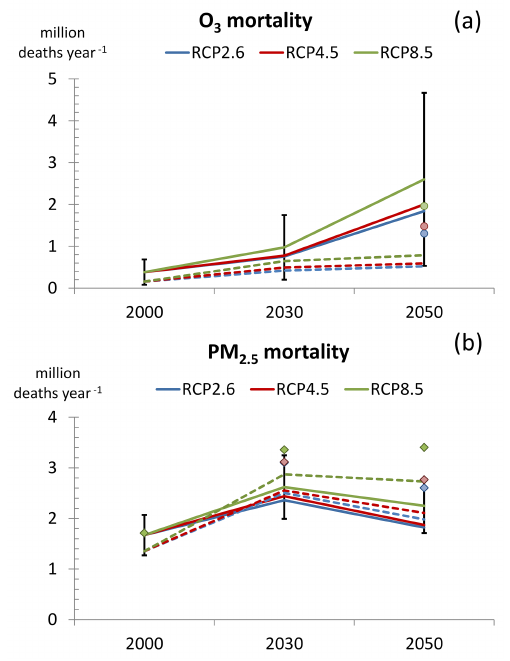
Figure 17. Trends in global burden on mortality of ozone (a) and PM 2 . 5 (b) from the years 2000 to 2050 from the ACCMIP multi-model ensemble (Silva et al., 2016) (full lines) and TM5- FASST (dashed lines) for three RCP scenarios. The error bar on the year 2000 is the ACCMIP 95% CI including uncertainty in RR and across models. CIs for 2030 and 2050 were not provided by ACCMIP; we use here the same relative error as for the year 2000. Dots (O 3 mortality) show the adjusted TM5-FASST ozone mortal- ities for RCP 2050, using baseline respiratory mortalities consis- tent with Silva et al. (2016). Diamonds (PM 2 . 5 mortality) show the TM5-FASST estimate including the urban increment parameteriza-